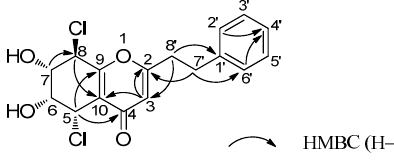
Figure 1. Selected HMBC correlations of Compound 1 .